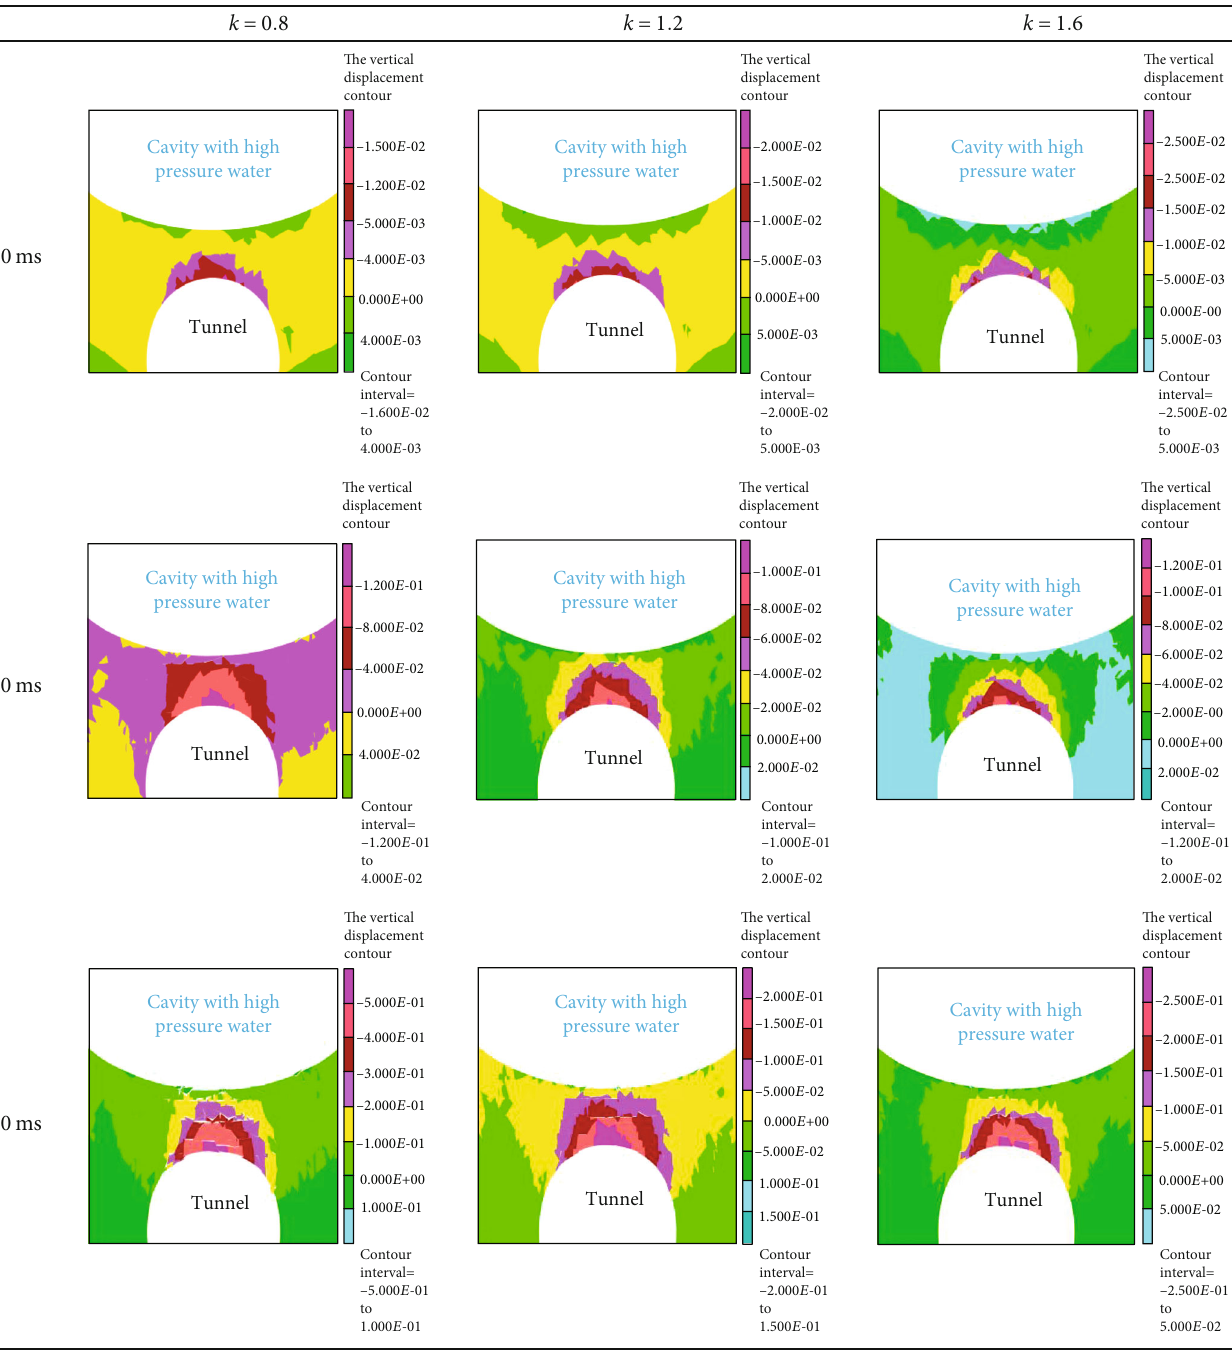
Table 9: The vertical displacement contour under the three cases of k = 0 : 8 , 1.2, and 1.6 at t = 10 , 40, and 80 ms. t k = 0 :